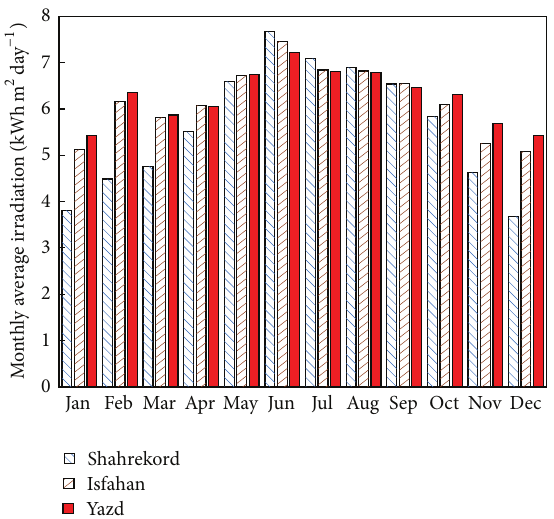
Figure 4: Monthly average solar irradiation for different